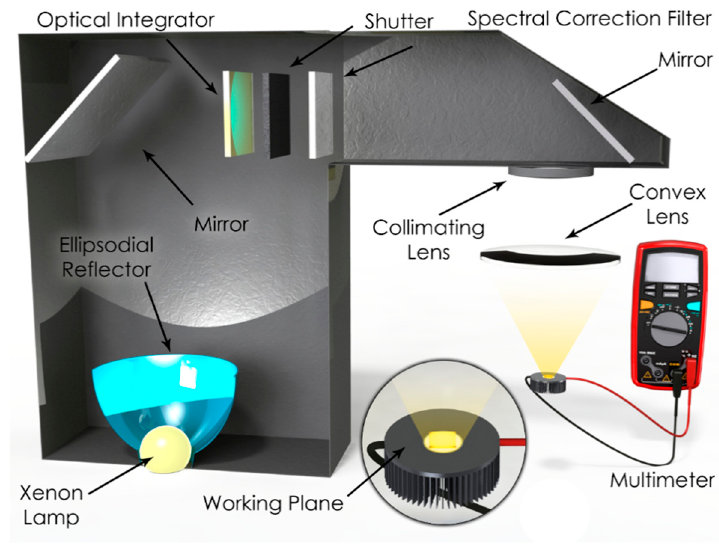
Figure 4. Schematic of the testing procedures for solar cells attached to the heat sink. The lenses allowed to test the performance under concentrated light conditions corresponding to up to 2000 suns.